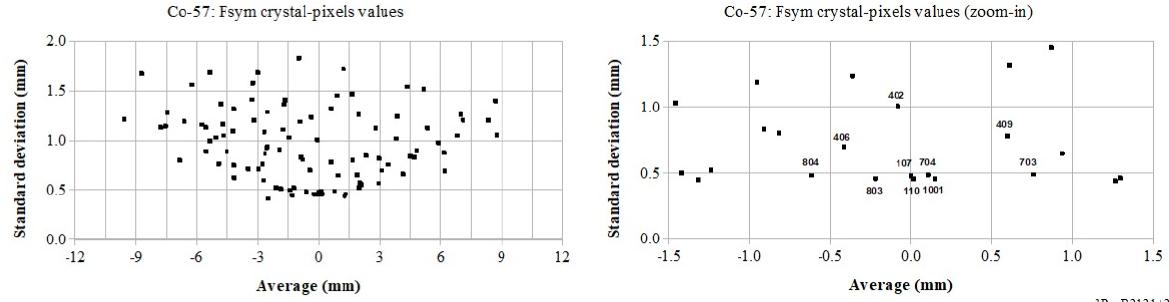
Figure A13. Histograms of average Fsym crystal-pixel values from Cs-137 ( left ) and Lu-176 self-activity ( right ) data-takings. The plots were drawn with 3.6- and 3.2-mm bins, respectively.